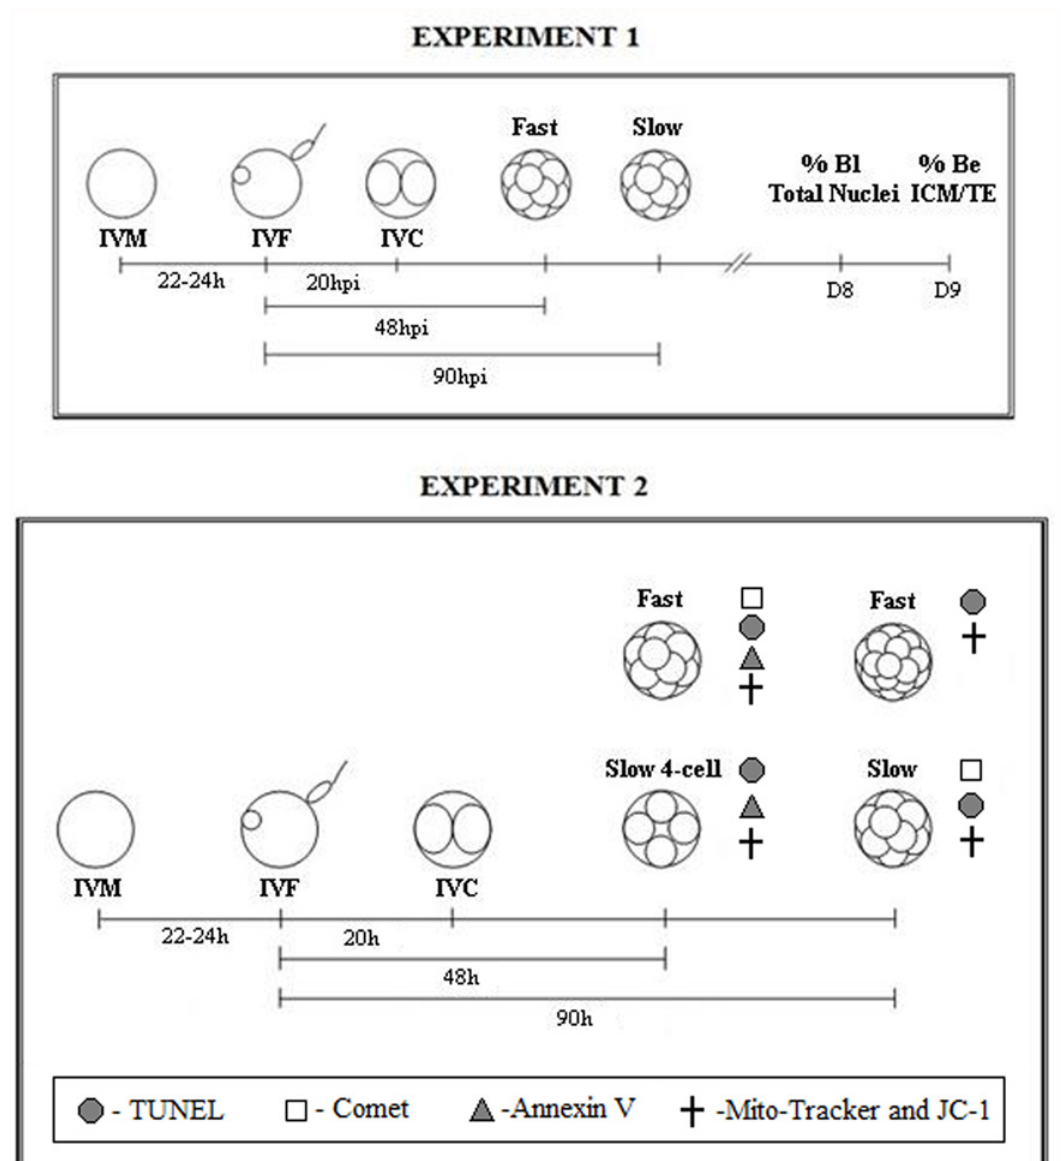
Fig 1. Experimental design. Experiment 1: Oocytes/embryos were subjected to in vitro maturation (IVM), in vitro fertilization (IVF) and in vitro culture (IVC). The embryos were classified according to the time to reach the fourth cell cycle as either Fast (48 h post-insemination — hpi) or Slow (90 hpi). The blastocyst rate (% Bl) and total nuclei count were assessed at eight days post-insemination (D8). To evaluate the hatching rate (% Be) and nuclei count of the inner cell mass (ICM) and trophectoderm (TE) of the hatched embryos were assessed on day 9 (D9). Experiment 2: The Slow group was further separated into two groups: those presenting exactly 4 cells at 48 hpi (Slow/4 cells) and those that reached the fourth cell cycle at 90 hpi (Slow). The cleavage and blastocyst rates, cell number, DNA fragmentation, mitochondrial membrane potential and signs of apoptosis or necrosis were evaluated in the embryos.